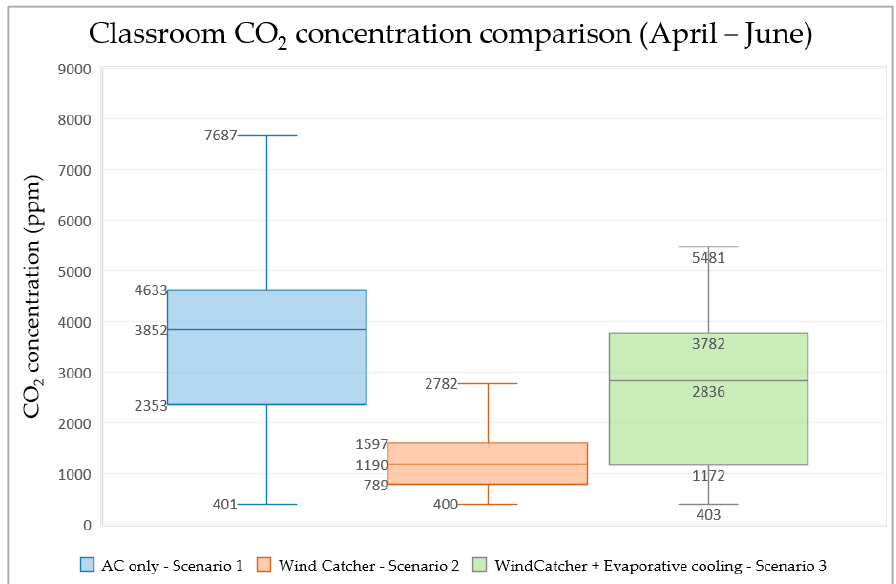
Figure 13. Relative humidity comparison across the three scenarios.